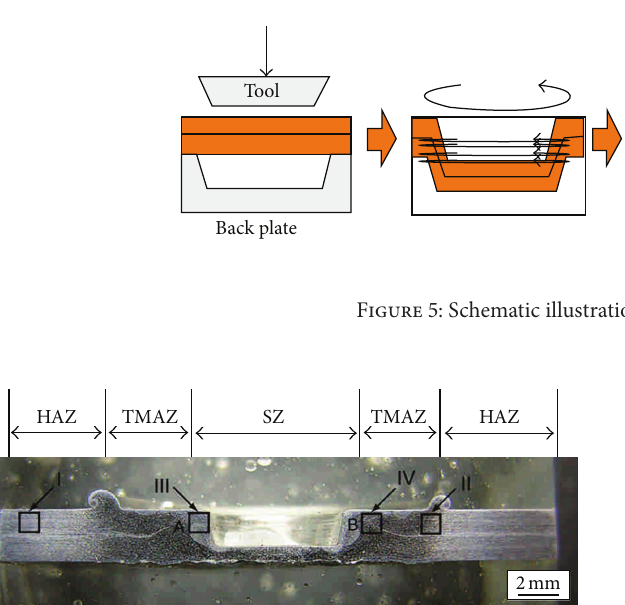
Figure 6: A typical micrograph of the cross-section of a friction stir spot weld